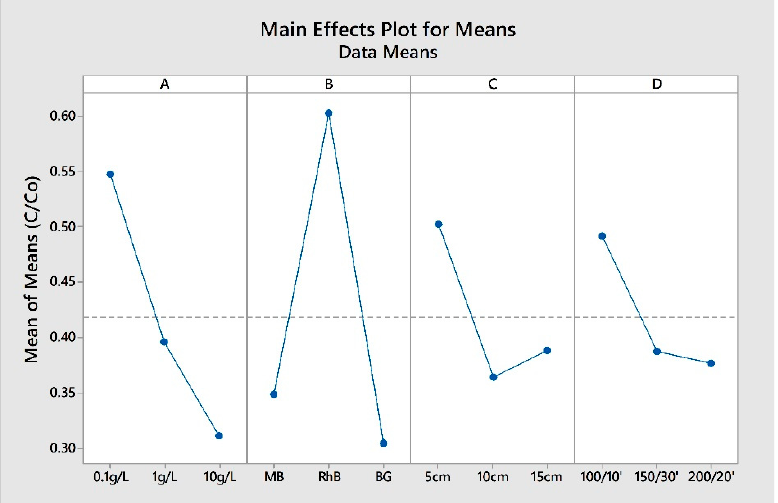
Figure 12. Qualitative effect of each factor on the final degradation of C/Co, where A is the amount of catalyst/pollutant (g/L), B is the pollutant, C is the distance from the light source and, D is the time protocol.